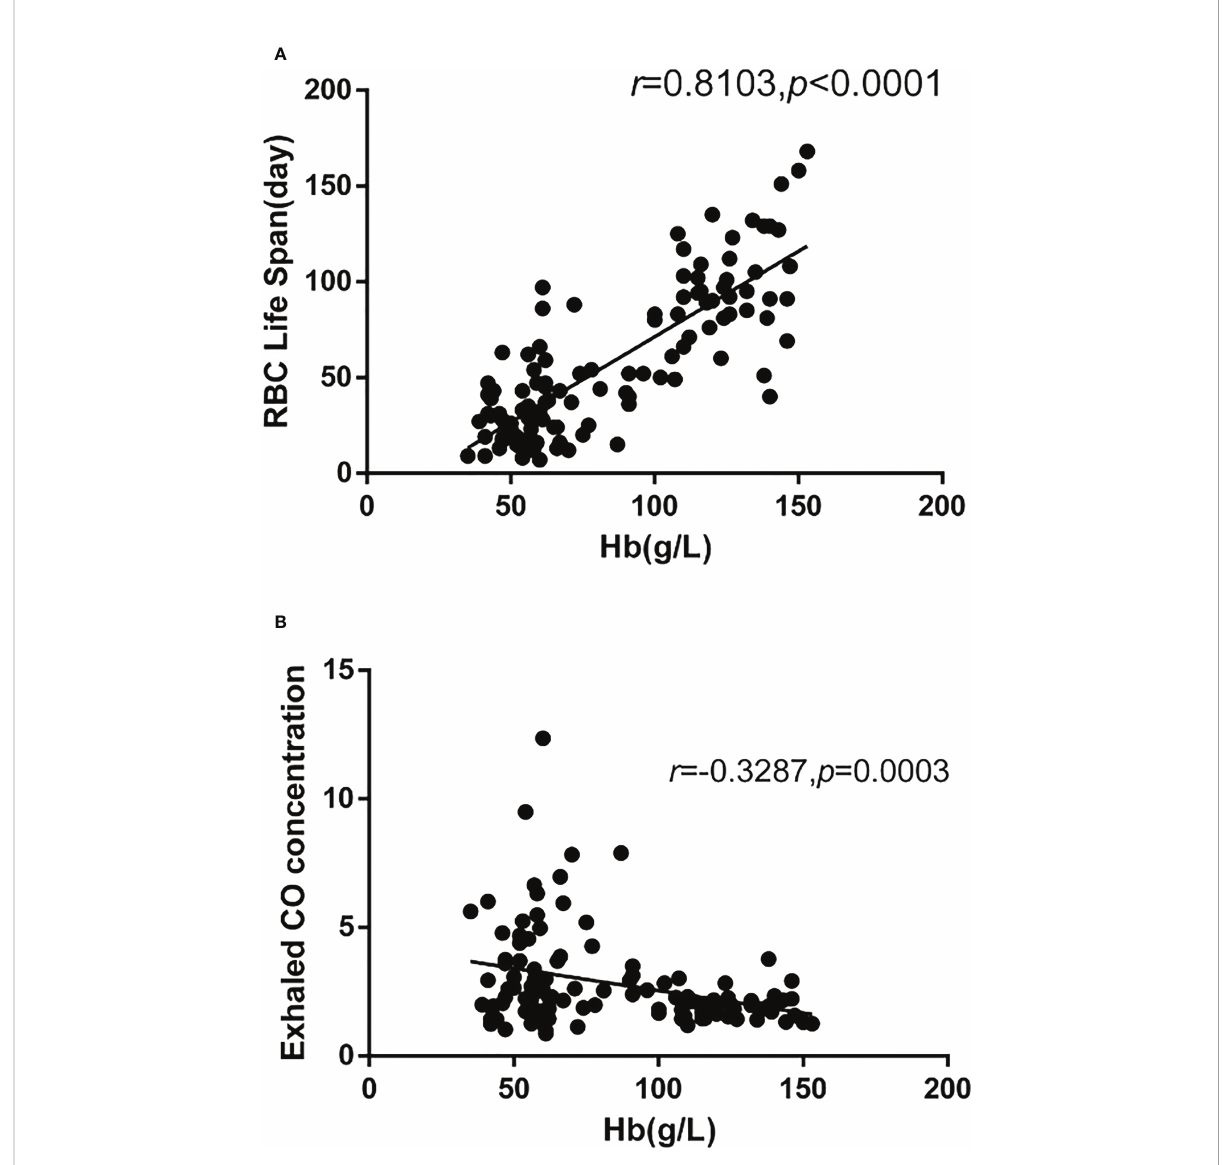
FIGURE 2 There were 115 cases in the MDS group and the control group. The correlation analysis results showed that: (A) The hemoglobin was signi fi cantly positively correlated with the RBC life span(r=0.8103, p<0.0001), (B) The hemoglobin was signi fi cantly negatively correlated with the concentration of CO (r=-0.3287,